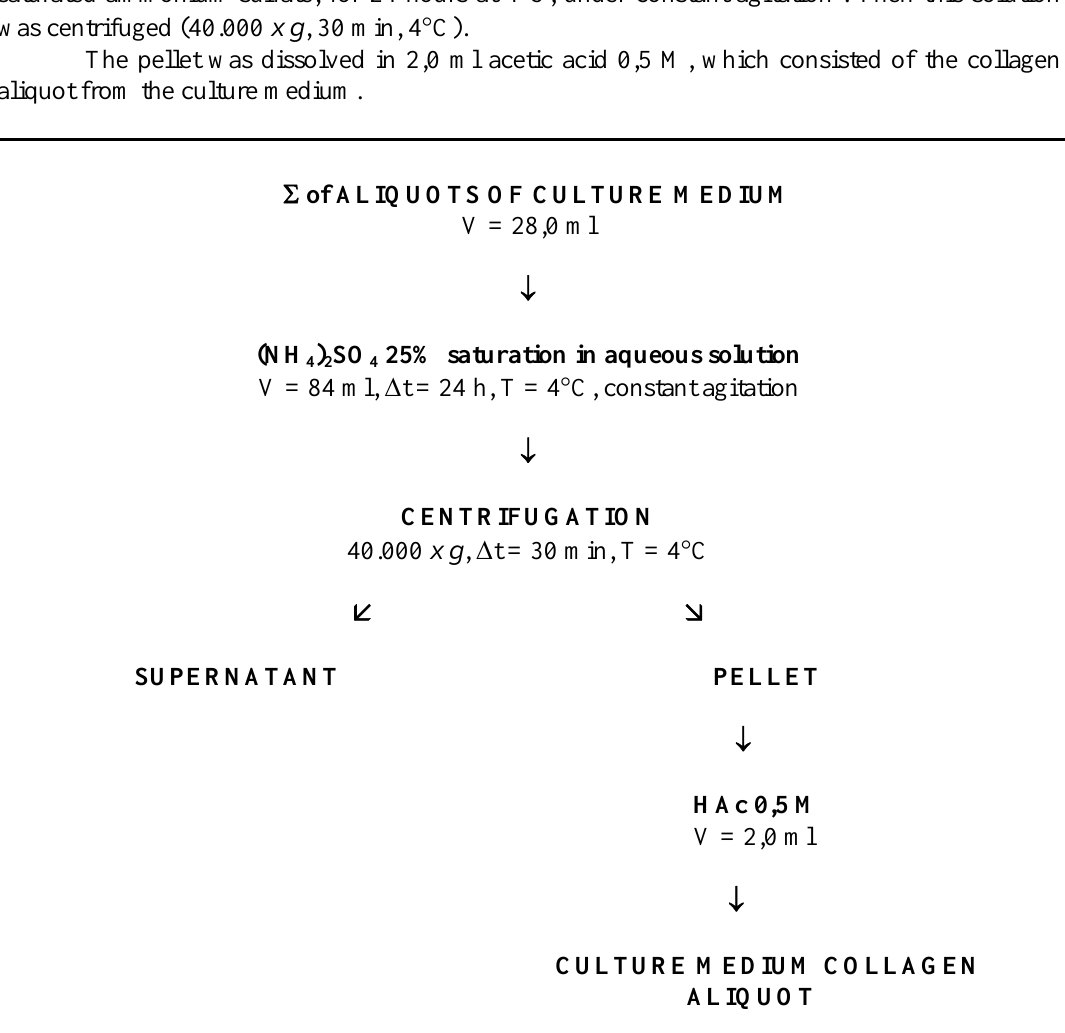
FIGURE 2 - Process of collagen extration from the culture medium. Collagen chromogenic precipitation with Sirius Red (TABLE 1, FIGURES 3, 4,